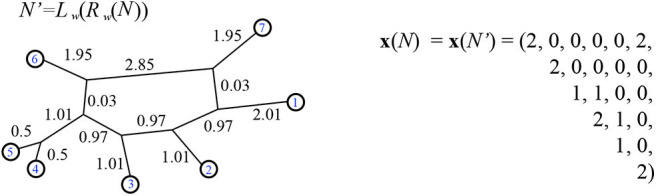
Using N from Figure 10, we find N′ as in the proof of Theorem 4.5. In the vector x(N) the first component is x1,2=21-0, since there are no non-trivial bridges traversed between leaves 1 and 2. As well, there are two consistent circular orders, with leaves 1 and 2 adjacent, found by twisting around the single non-trivial bridge. The 19th entry is x5,6=21-1, since the path between leaves 5 and 6 traverse the non-trivial bridge. Here the minimum path distance vector is:dN=(3.99,4.96,6.43,6.43,6.84,3.99,2.99,4.46,4.46,4.93,3.96,3.49,3.49,3.96,4.93,1,3.49,6.34,3.49,6.34,6.75).